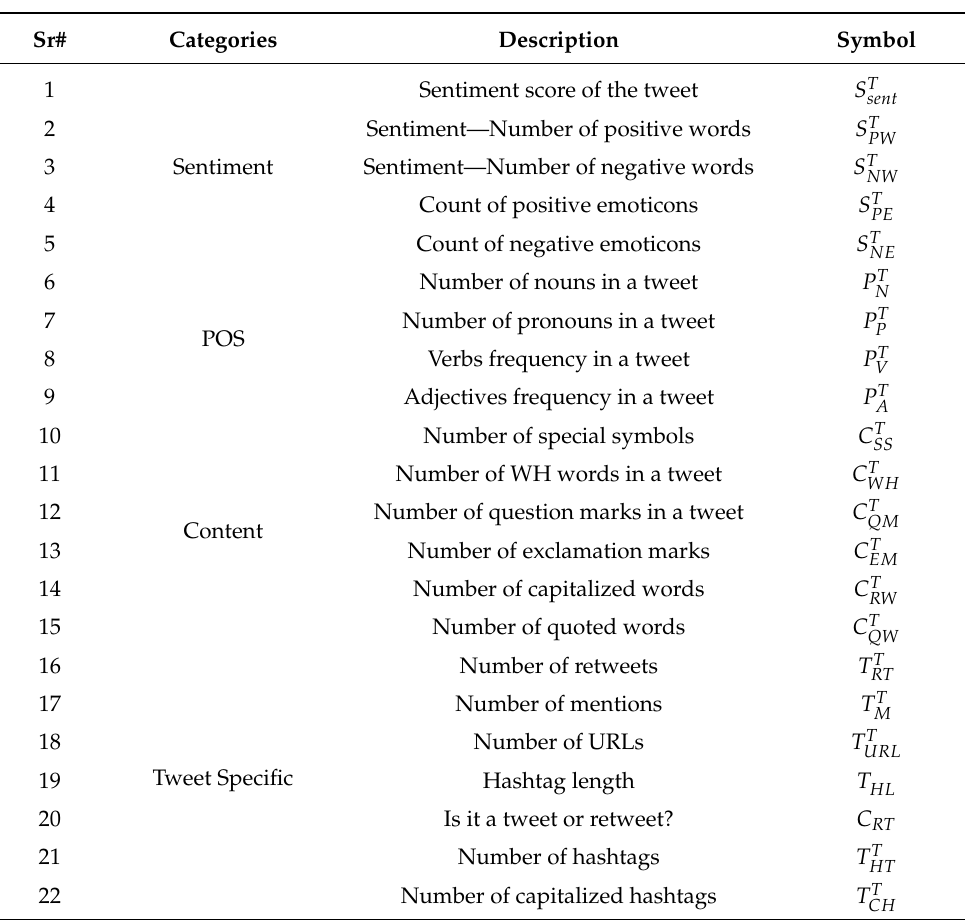
Table 2. Proposed feature sets for